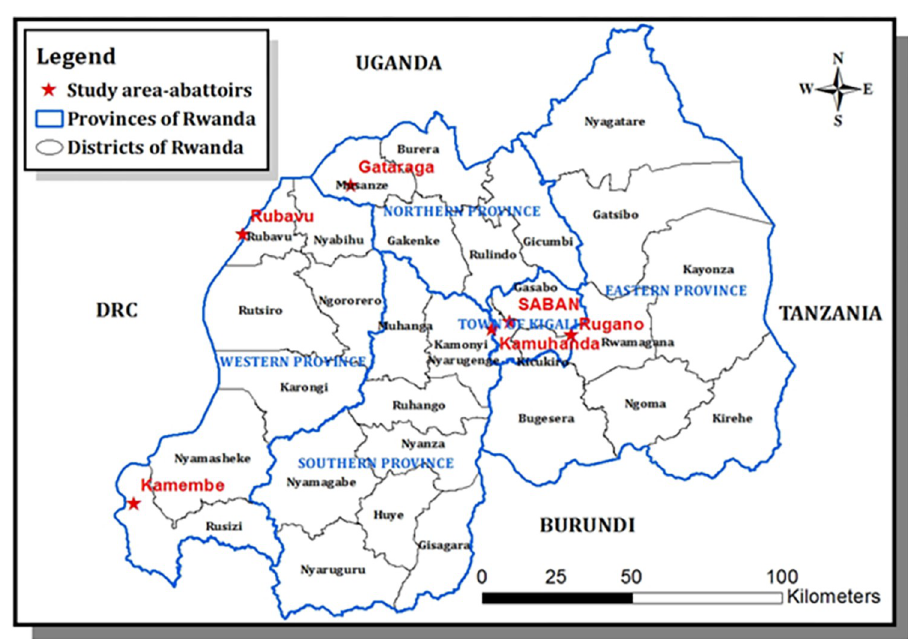
Fig 1. Map of Rwanda with provinces and districts and red stars show the locations of abattoirs visited in this study. This map was produced in the ArcGis Desketop 10.1–10.8.2 of the University of Rwanda with concurrent use and Education licence. Spatial data (shapefiles) are freely available from DIVA-GIS. (https://gadm.org/download_ country.html and https://diva-gis.org/gdata).